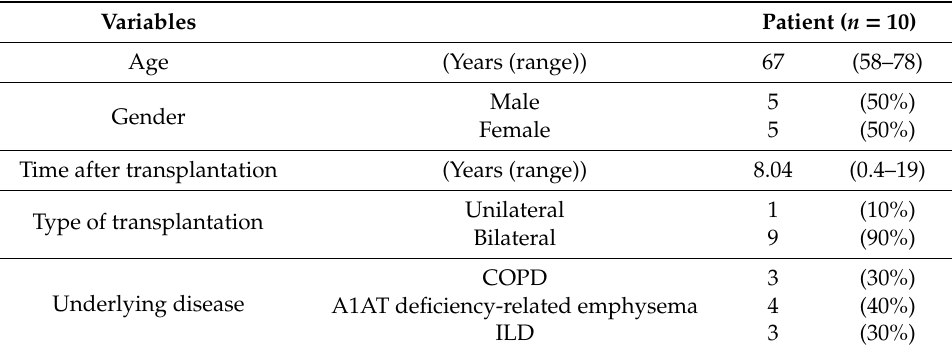
Table 1. Baseline